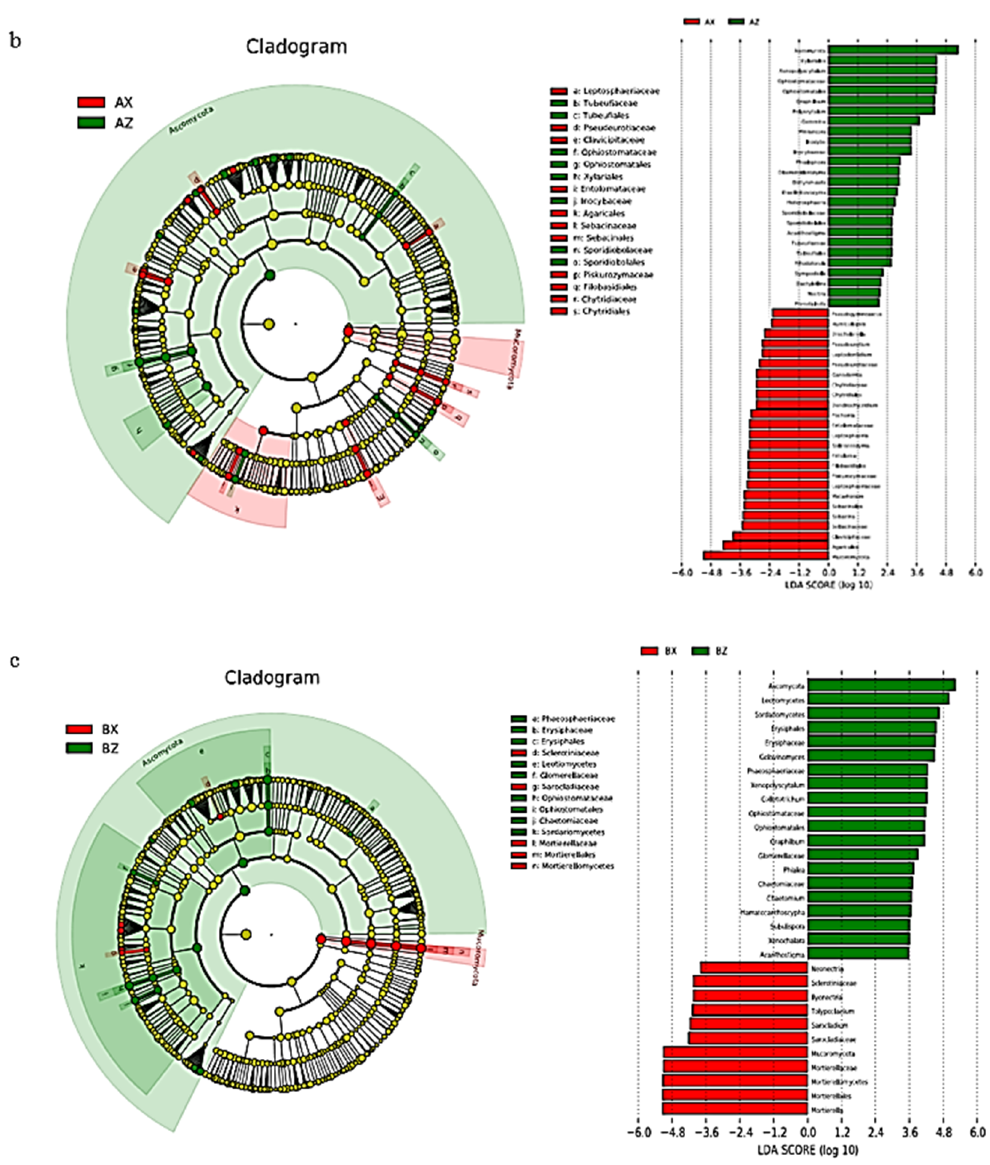
Figure 8. LEfSe analysis of litter-layer fungi. Cluster tree of litter-fungus LEfSe analysis in ( a ) Korean pine plantation forest and original Korean pine forest, ( b ) di ff erent litter layers of Korean pine plantation forest, and ( c ) di ff erent litter layers of original Korean pine forest.